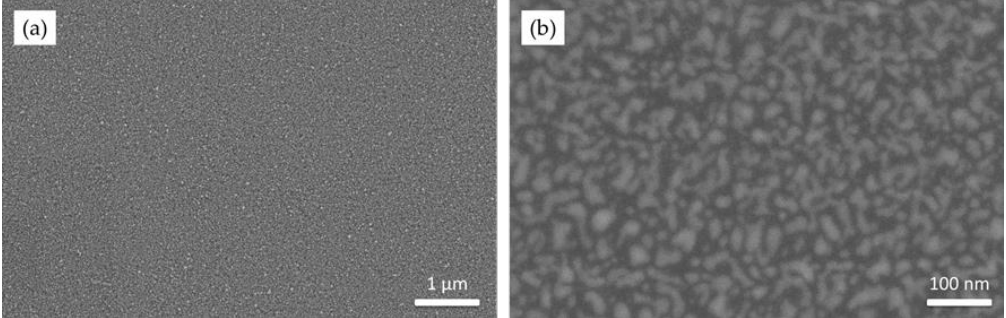
Figure 5. SEM images at ( a ) low and ( b ) high magnification of silver coating deposited on reference silicon